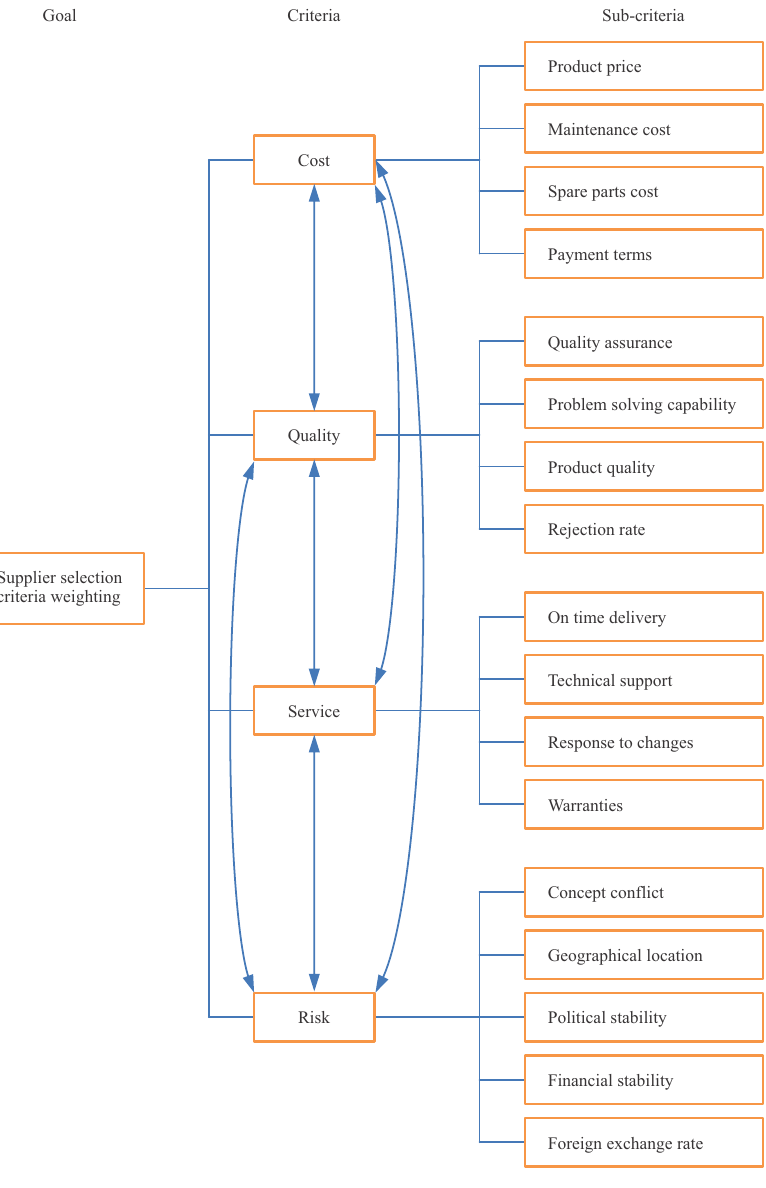
Fig. 3. ANP model to weight supplier selection